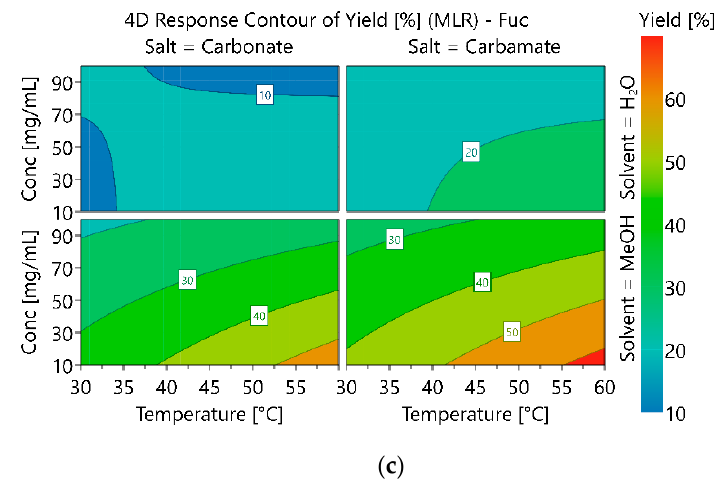
Figure 5. Plots of the model for Fuc generated by MODDE: ( a ) Summary of fit shows a lower significance of the model; ( b ) plot of coefficient values for scaled and centered factors show significant factors according to the model; ( c ) the 4D response contour plot of yield predicts yields of amination in dependence on qualitative and quantitative factors.